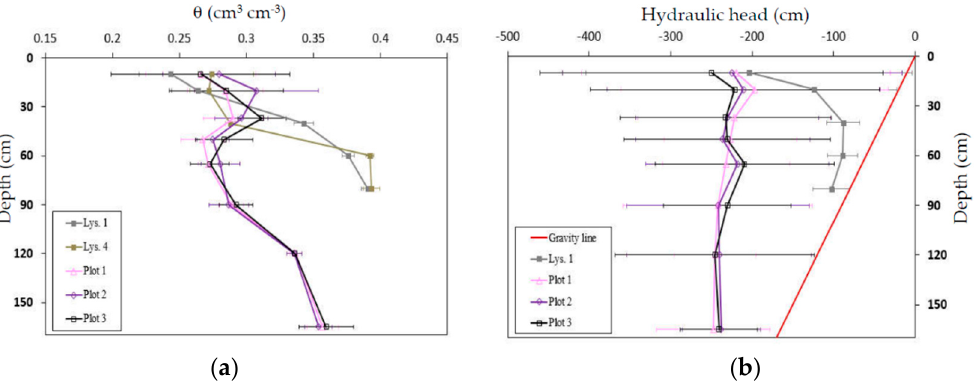
Figure 2. Average profile of water content ( a ) and hydraulic head ( b ) observed from 22 February 2013 to 31 January 2015 in each instrumented field plot and lysimeter. Standard deviations are calculated from the daily data observed at each instrumented depth.